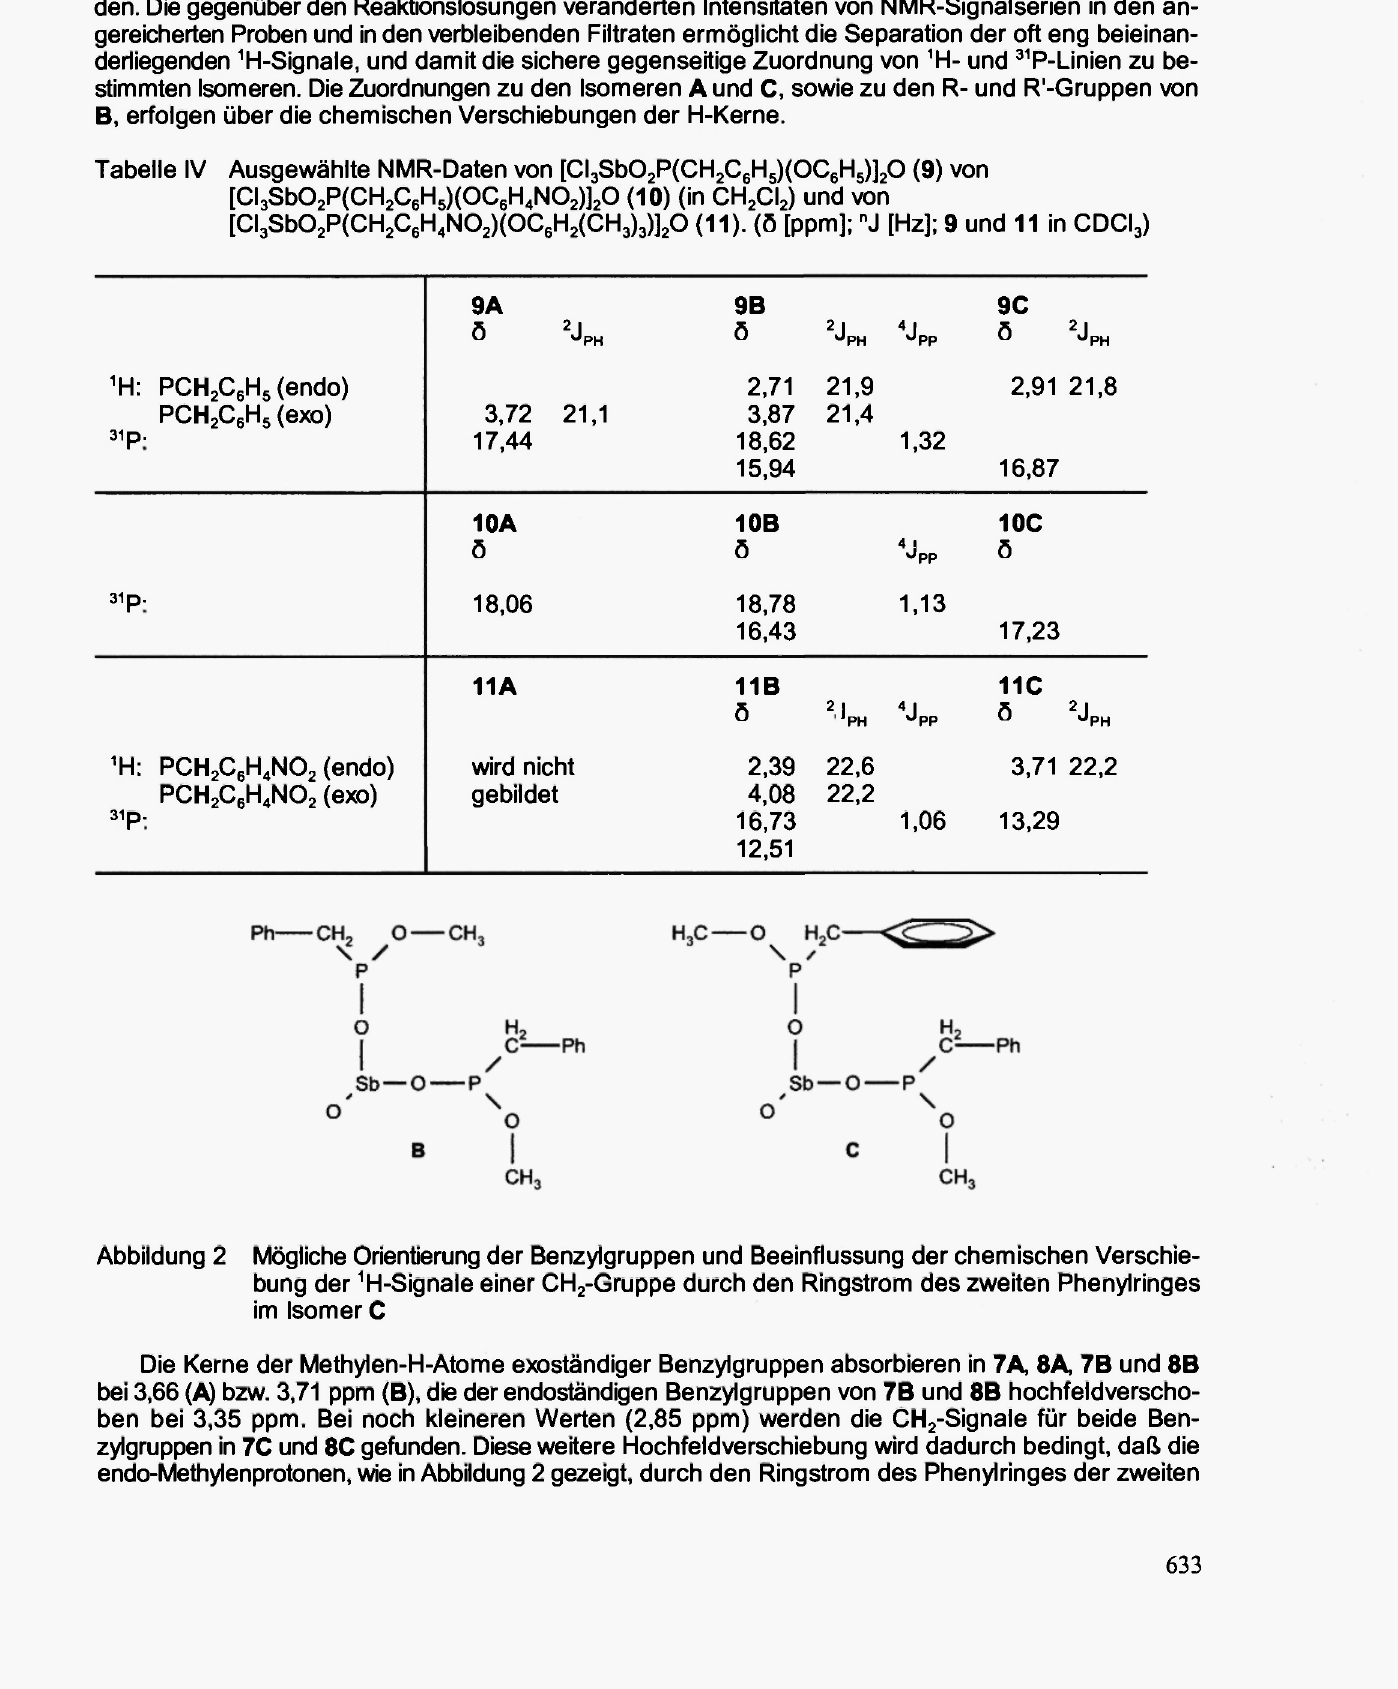
den. Die gegenüber den Reaktionslösungen veränderten Intensitäten von NMR-Signalserien in den an- gereicherten Proben und in den verbleibenden Filtraten ermöglicht die Separation der oft eng beieinan- derliegenden 1 H-Signale, und damit die sichere gegenseitige Zuordnung von 1 H- und 31 P-Linien zu be- stimmten Isomeren. Die Zuordnungen zu den Isomeren Α und C, sowie zu den R- und R'-Gruppen von B, erfolgen über die chemischen Verschiebungen der H-Kerne. Tabelle IV Ausgewählte NMR-Daten von [CI 3 Sb0 2 P(CH 2 C 6 H 5 )(0C 6 H 5 )] 2 0